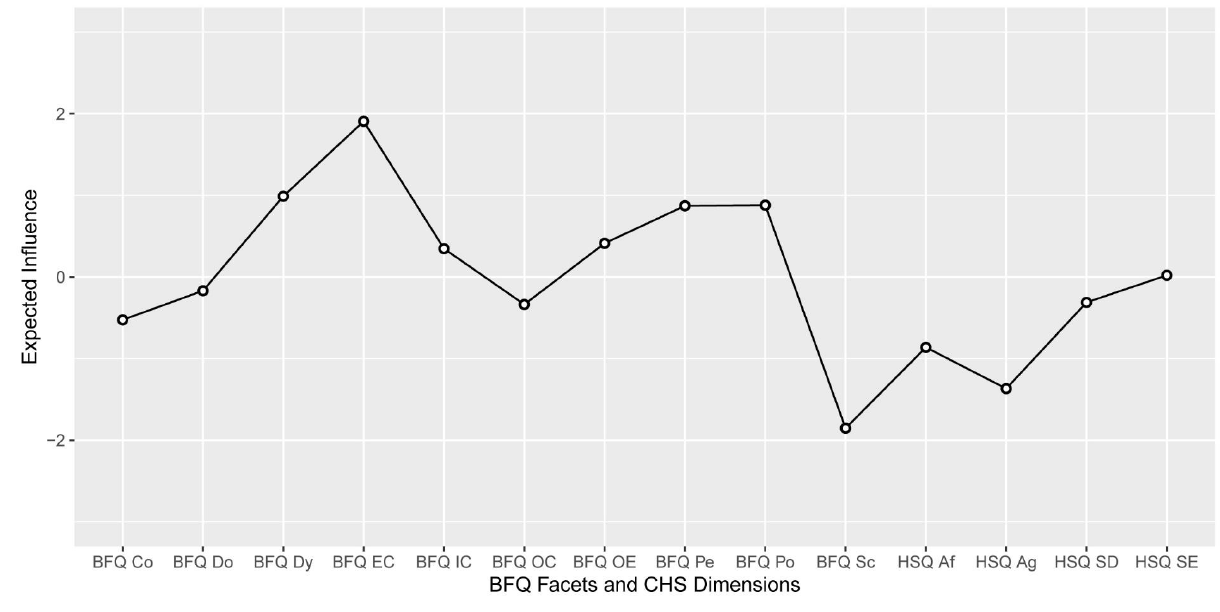
Figure 3. Network of Humor Styles dimensions and Big Five Personality facets: Expected influence centrality estimates ( n = 462). Note: The Humor Style Questionnaire dimensions and Big Five Questionnaire personality traits are listed on the X-axis. Expected Influence as standardized z-score are reported on the Y-axis. Big Five Questionnaire (BFQ) ten facets. Dy: Dynamism; Do: Dominance; Co: Cooperativeness; Po: Politeness; Sc: Scrupulousness; Pe: Perseverance; EC: Emotion Control; IC: Impulse Control; OC: Openness to Culture; OE: Openness to Experiences. Humor Style Questionnaire (HSQ) four dimensions. Af: Affiliative; SE: Self-enhancing; Ag: Aggressive; SD: Self-defeating.